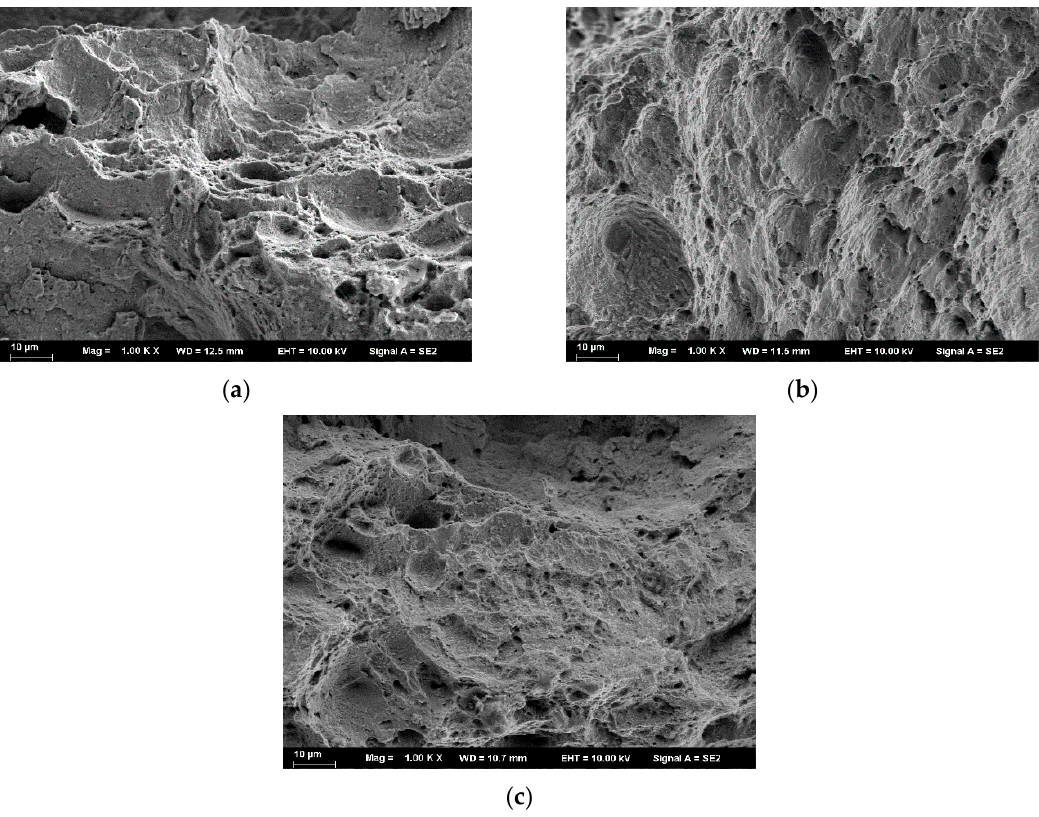
Figure 8. Fracture surfaces of impact-tested specimens with three typical modes of droplet transfer: ( a ) one drop per multiple pulses (ODMP); ( b ) one drop per pulse (ODPP); ( c ) multiple drops per pulse (MDPP).